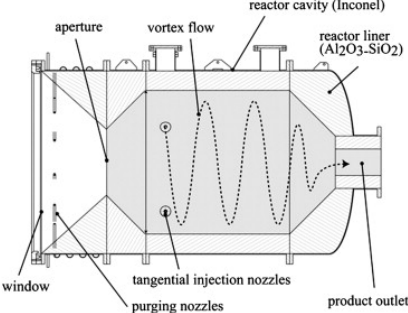
Figure 11. Scheme of the reactor configuration proposed by Z’Graggen and co-workers. Reprinted from [116] with permission from